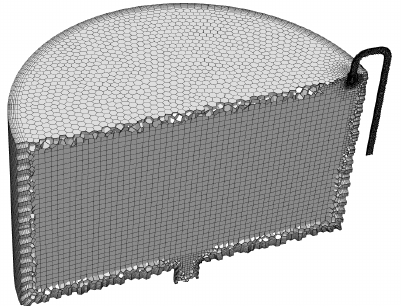
Figure 5. Illustration of poly-hexcore mesh with 420 thousand mesh elements representing 3D fluid domain used in CFD simulations.